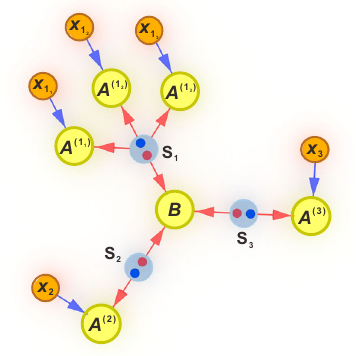
Fig. 3 | Experimental results. a Estimation of the branch parties' probability dis- tributionsconditionedtoasuccessfulGHZ-stateprojectioninthecentralnode.The distributions are obtained by normalising the raw experimental data in each mea- surement setting. b The measured results for the three inequalities for testing full